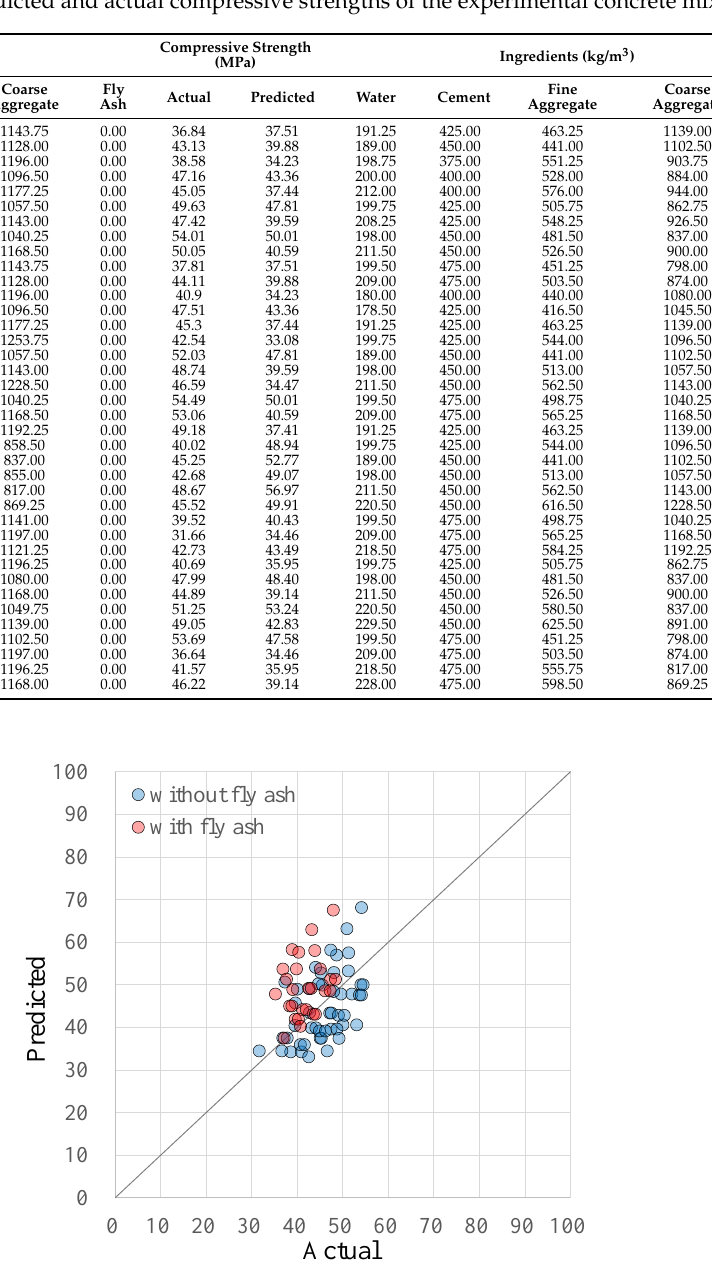
Figure 5. Comparison of predicted compressive strength with the actual strength of the 76 experimental concrete mixtures in [15] (Unit: MPa).